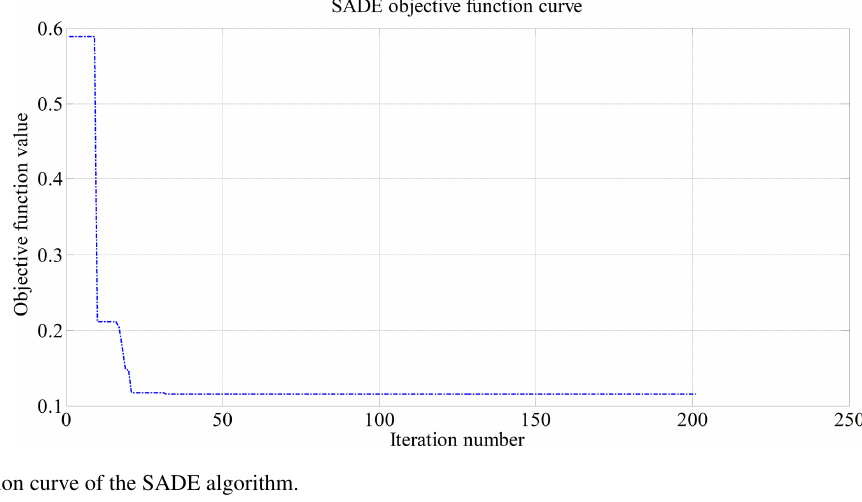
Figure 6. Optimization curve of the SADE algorithm.